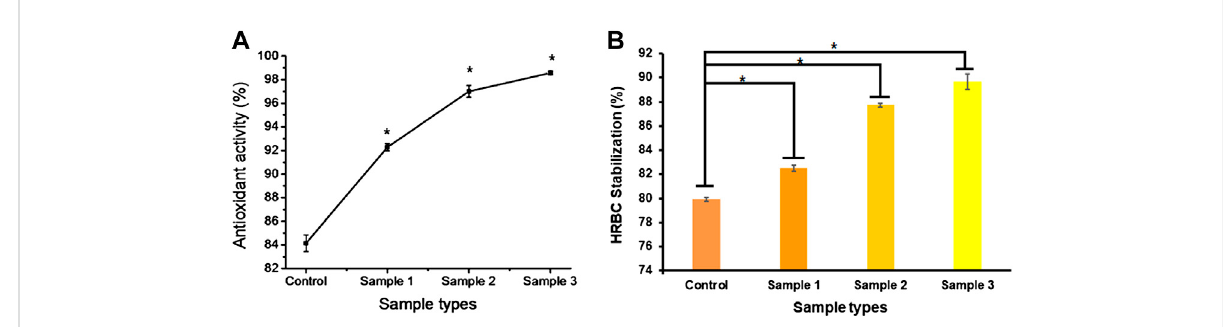
FIGURE 9 In vitro anti-oxidative (A) and anti-in fl ammatory (B) effects of bio-polymeric beads indicate signi fi cant antioxidant activity and cell lysis protection by natural components. Here, * indicates the signi fi cant difference between samples ( p < 0.05).